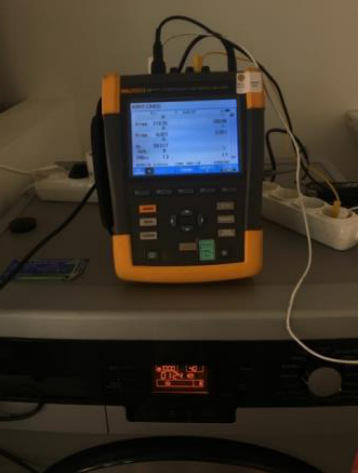
Figure 3. Harmonic measurement of a washing machine.